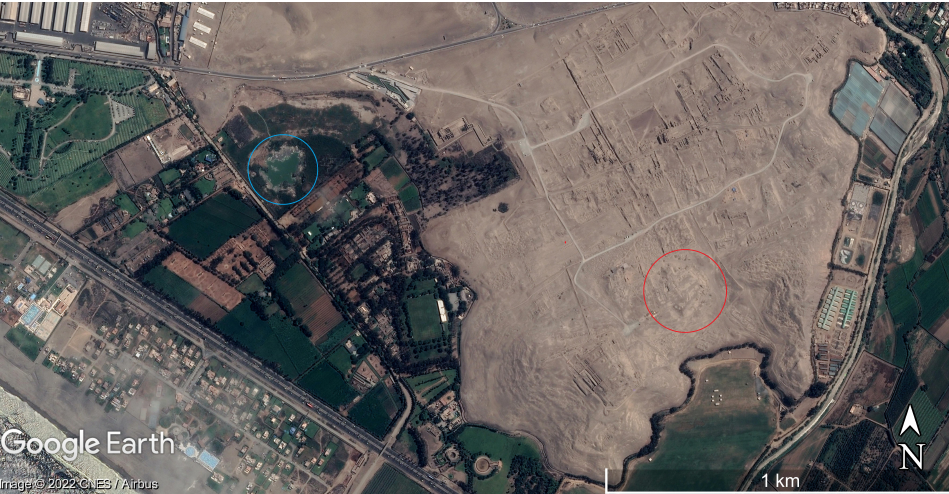
Figure 4. blue circle, respectively. Archaeological and geological inferences on El Niño events were argued for by the authors